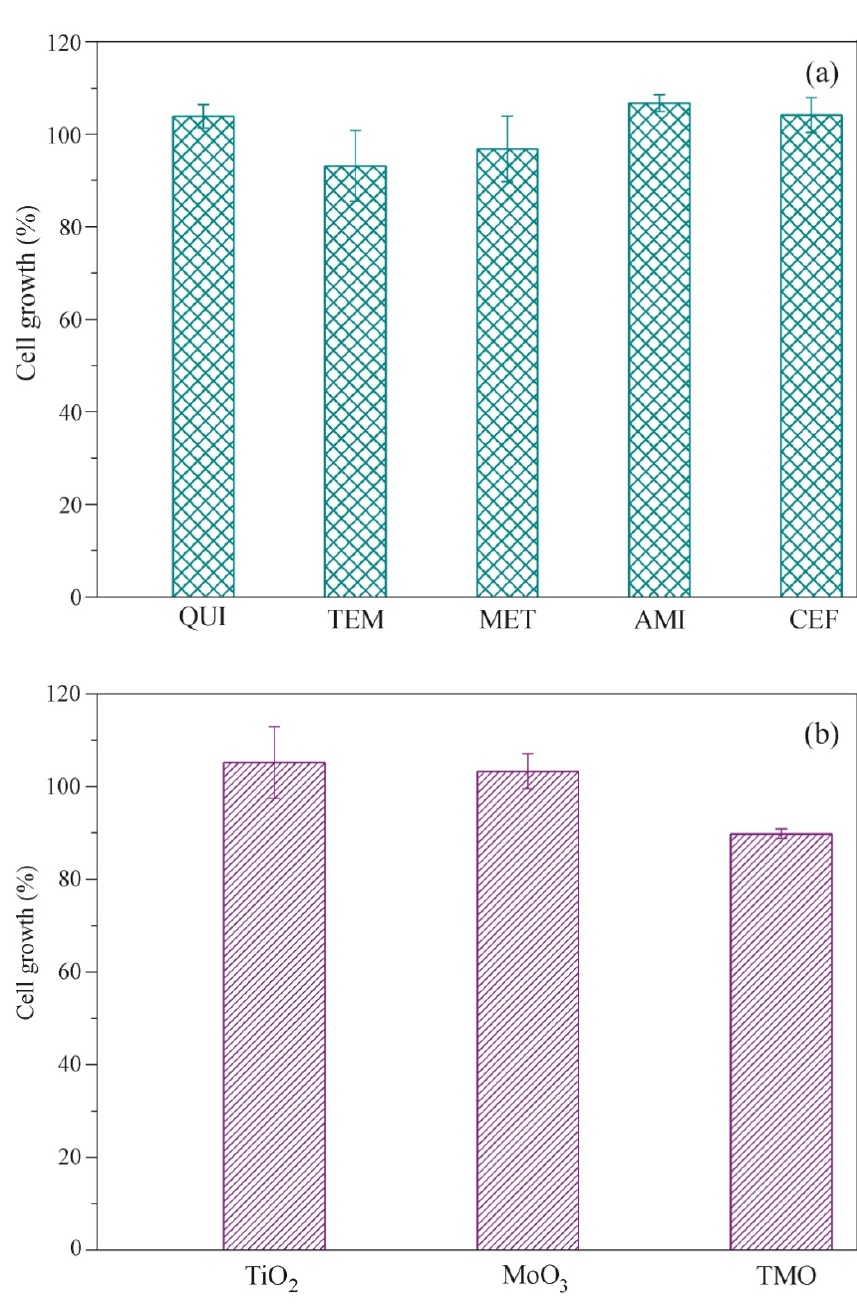
Figure 12. Effects of pesticides/pharmaceuticals solutions (0.05 mmol/dm 3 ) ( a ) and aqueous sus- pension of TiO 2 , MoO 3 , and TMO (1.0 mg/cm 3 ) after filtration ( b ) on the growth of the H-4-II-E cell line.